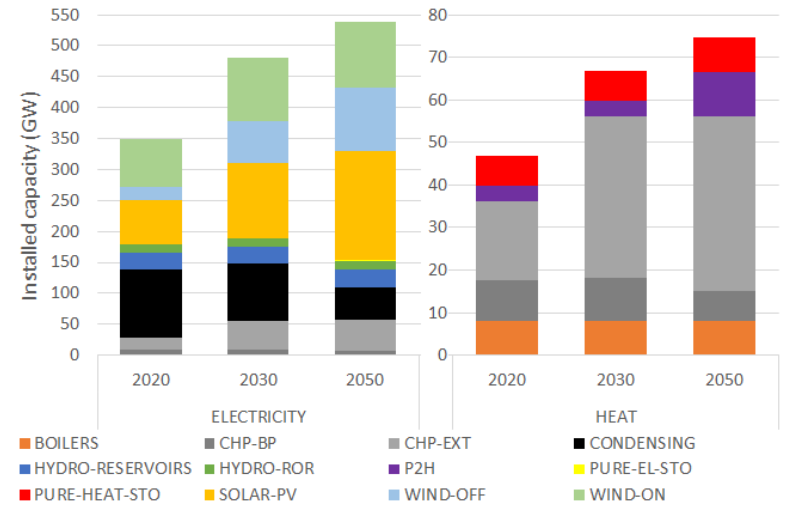
Figure 2. Installed capacity in the countries in focus (GW). The types considered are heat boilers, combined heat and power back pressure (CHP-BP), and CHP extraction (CHP-EXT), electricity-only thermal units (condensing), hydro reservoirs, hydro run-of-river (ROR), P2H, other electricity storage (PURE-EL-STO), heat storage (PURE-HEAT-STO), solar PV, wind offshore (WIND-OFF), and wind onshore